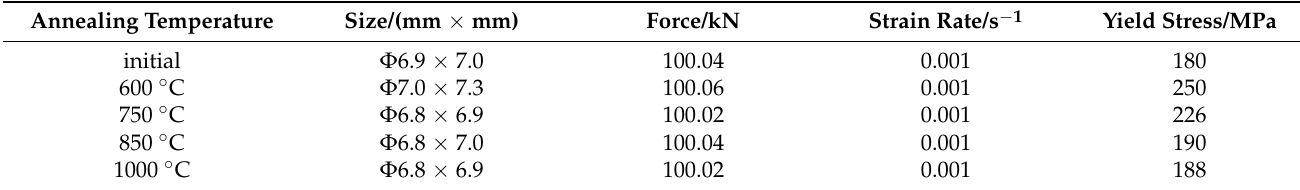
Figure 9. Comparison of specimens after quasi-static compression test. Table 1. Experimental data of quasi-static compression.